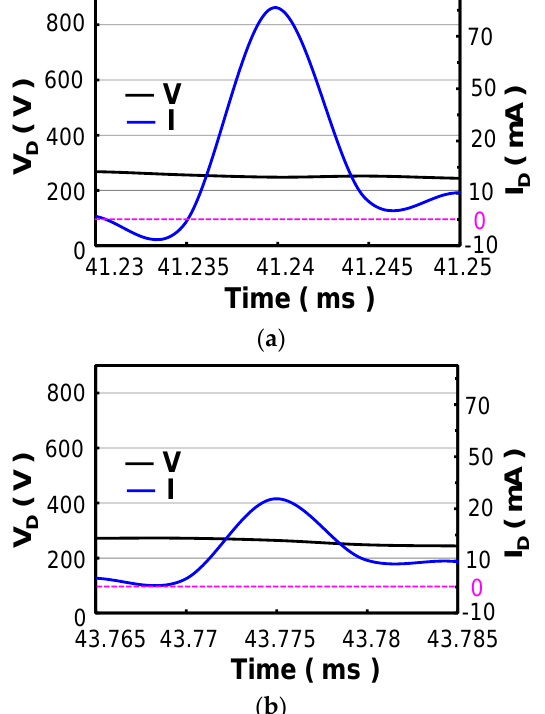
Figure 9. Zoomed–in view of the voltage and current waveforms in Figure 5c, during the time periods ( a ) b1 and ( b ) b2.